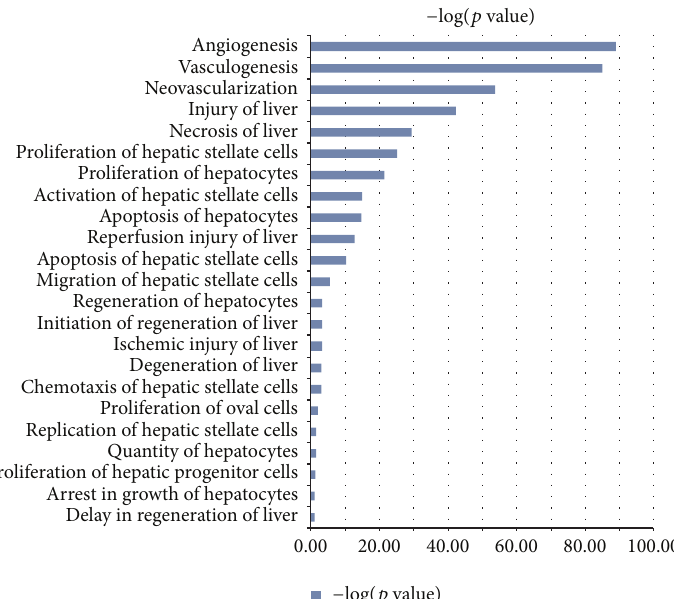
Figure 6: Functional analysis of cellular processes altered by L-MSC-conditioned medium. Proteins present in serum-free MSC-CM were analyzed using Mass Spectrometry. Out of 2060 proteins identified, 861 related to functional networks in Ingenuity Pathway Analysis. Top cellular processes involved proliferation of hepatocytes and nonparenchymal